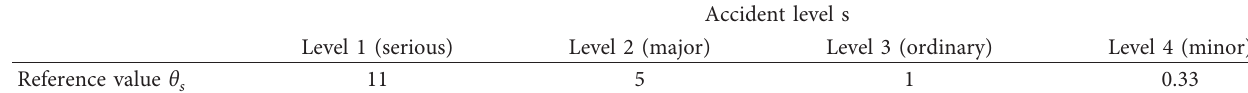
Table 3: Reference value of weighting coefficient of accident levels.